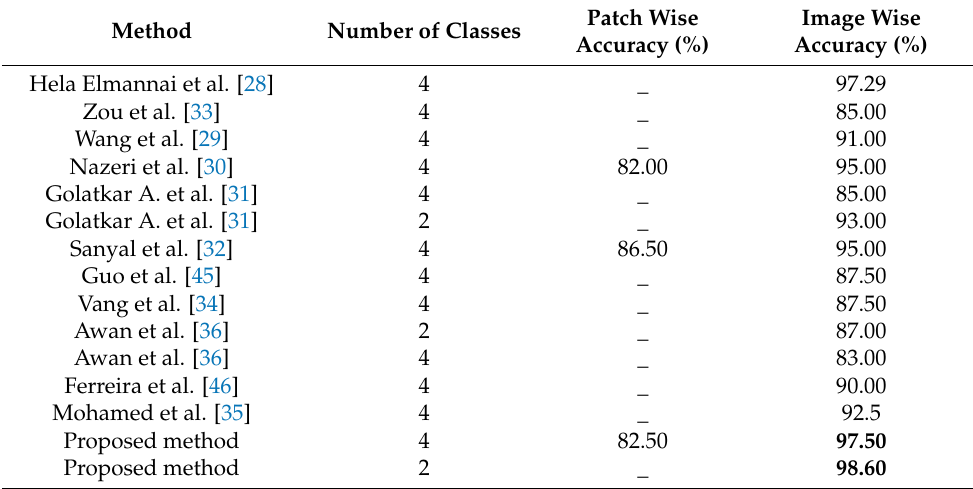
Table 6. Comparison of the proposed method with some state-of-the-art methods on the ICIAR BACH dataset. Bold font indicates the highest value.